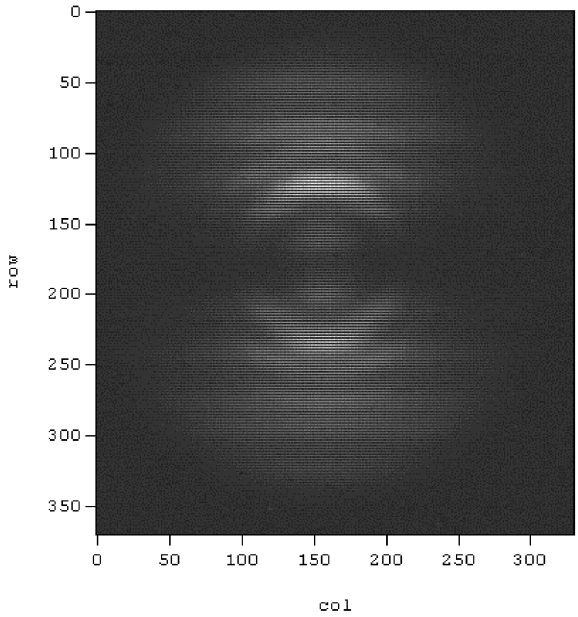
FIG. 4. Beam-core polarized OTR interference pattern. A qualitative comparison of Figs. 4 and 5 indicates that the beam-core OTRI has sharper lobes than does the whole-beam pattern. The 28% beam core thus has smaller divergence than does the entire beam.